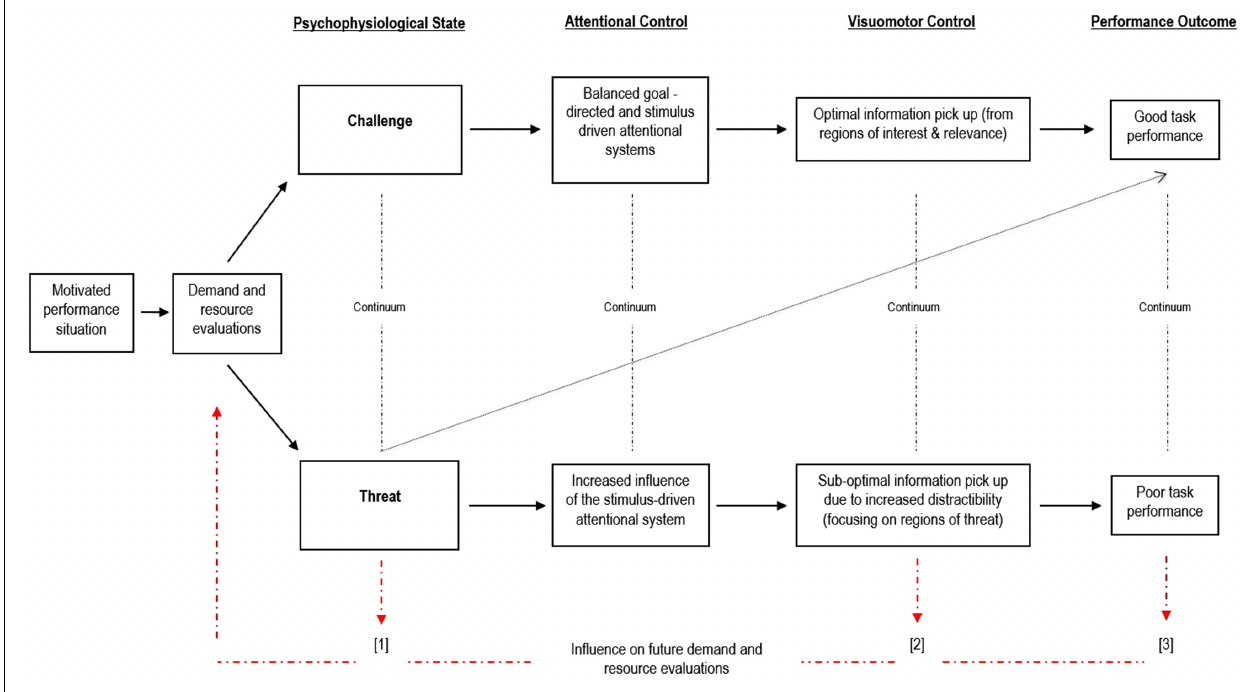
FIGURE 1 | An integrative framework of stress, attention, and human performance. The rectangular boxes highlight the opposing psychophysiological responses to stress (challenge or threat state) that result from the demand and resource evaluation process, and their subsequent influence on attentional control and visumomotor performance. The diagonal dashed line represents compensatory strategies (e.g., increasing effort) that can be adopted to prevent a threat state from influencing performance. The red dashed lines represent the cyclical nature of evaluations of stress, and the influence of a threat state on future demand and resource